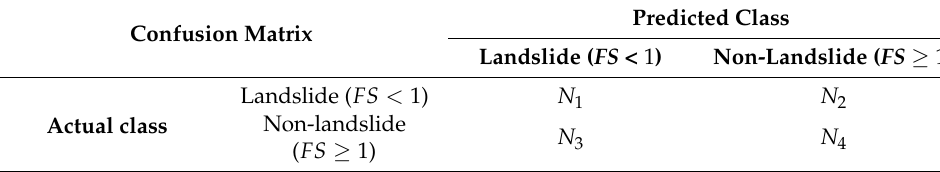
Table 1. The classification of the confusion